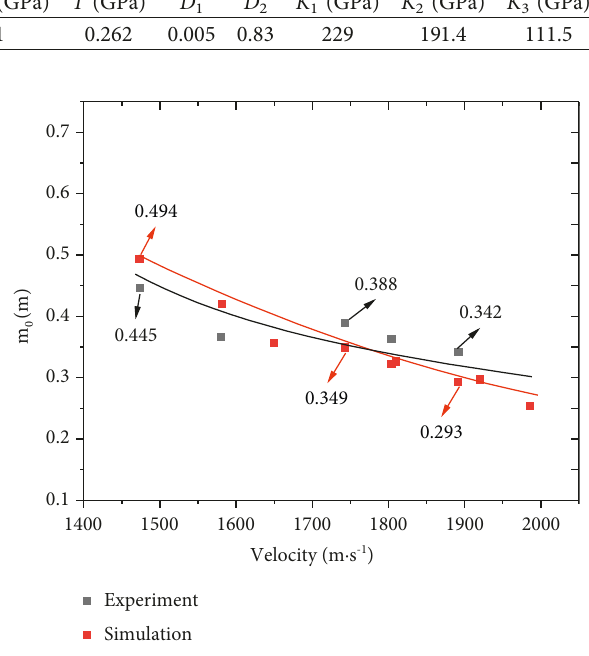
Figure 9: Mass loss of the projectile vs.